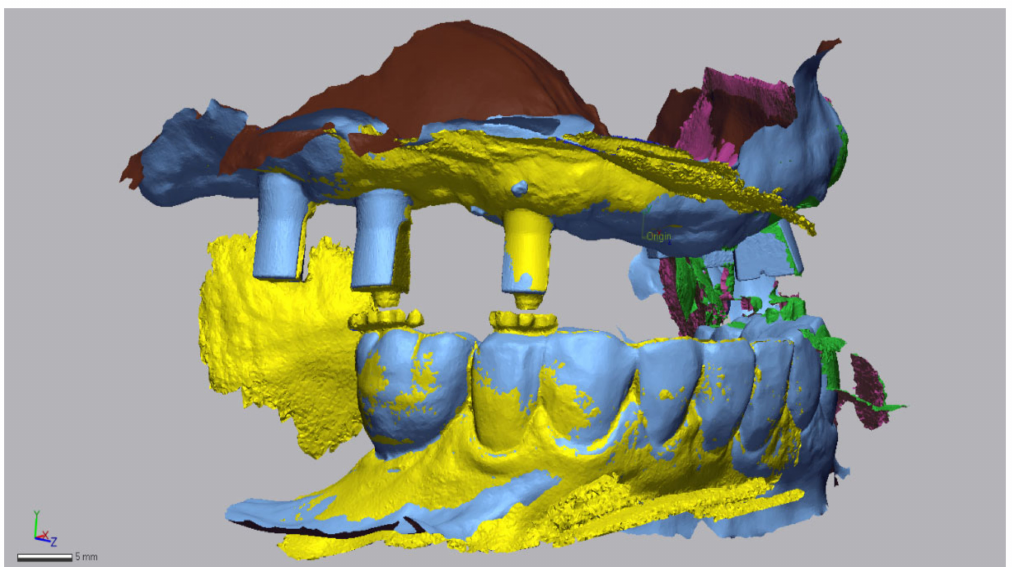
Figure 11. STL-set T2: Scan data of the digital bite registration. A digital impression of the maxillary arch with dual-function scan bodies, a digital mandibular antagonist impression and two bilateral buccal bite-scans with adjusted bite pillars inserted into the screw holes of the dual-function scan bodies (Geomagic Control X, 3D Systems Inc., Rock Hill, SC,